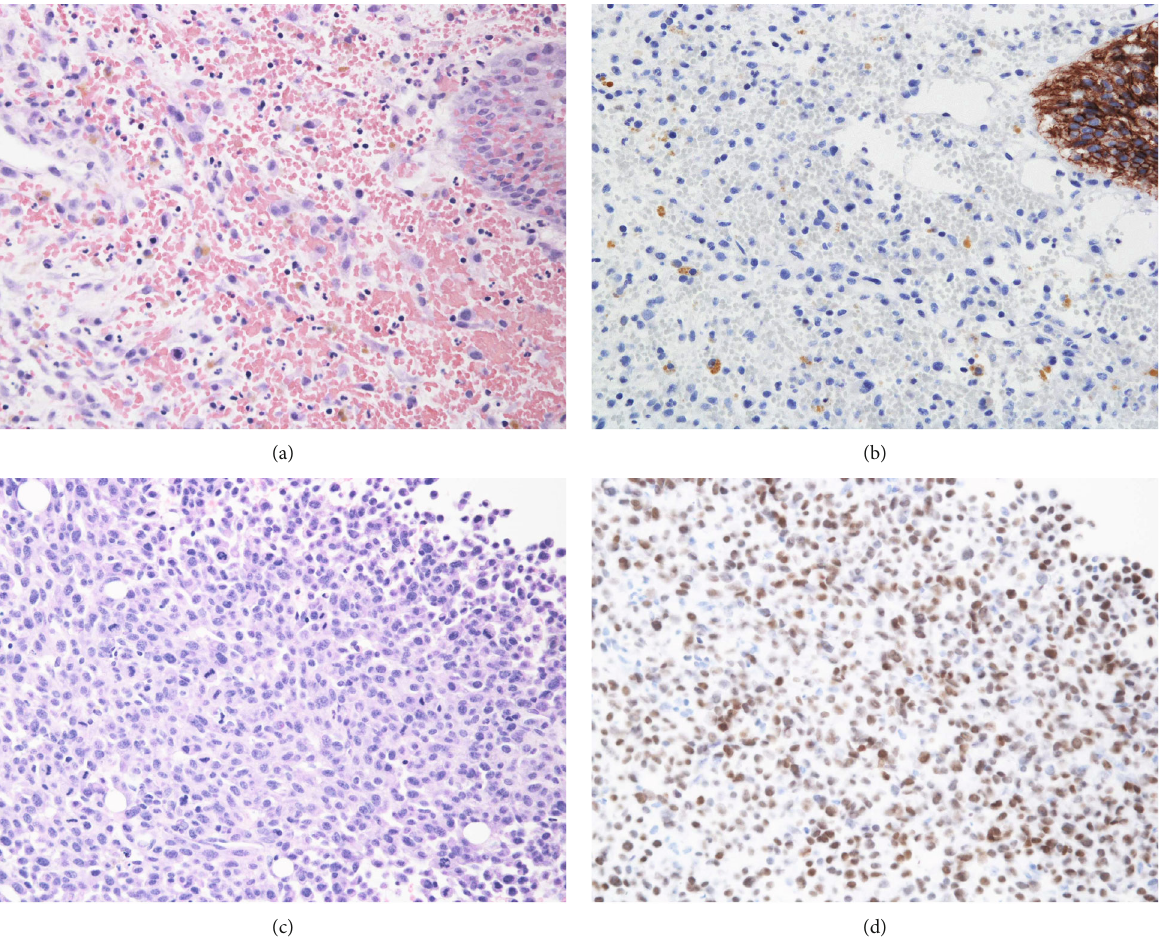
Figure 3: (a) HE staining and (b) immunohistochemical staining for E-cadherin expression of the tumor when transurethral electrocoagulation was performed. (c) HE staining and (d) immunohistochemical staining for GATA3 from the second bone marrow